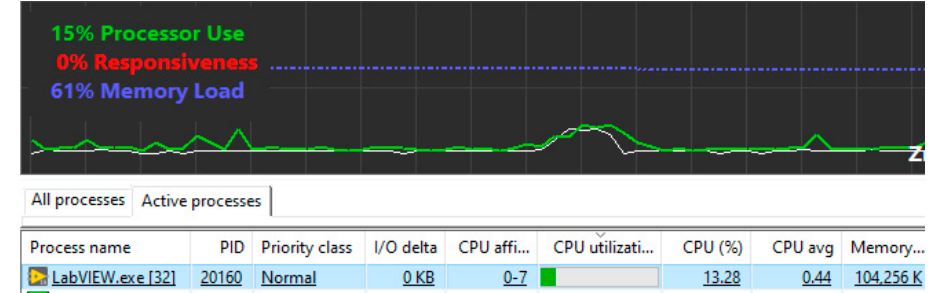
Figure 14. The graphical user interface of Lasso software.